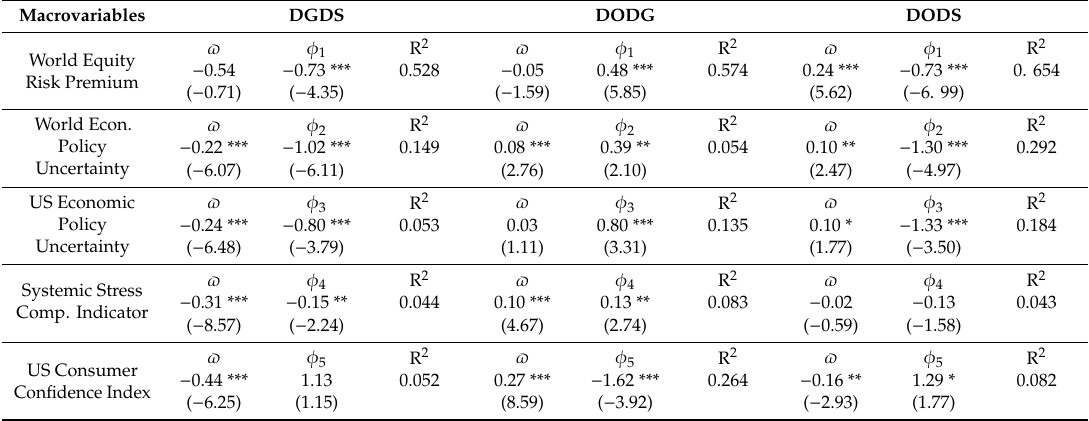
Table 5. Dynamic conditional correlations and macro-variables. Sample: 2000m11 - 2018m10 (216 Observations). Macrovariables DGDS DODG DODS